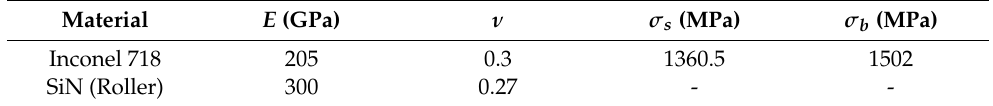
Table 2. Mechanical properties of Inconel 718 and burnishing roller.